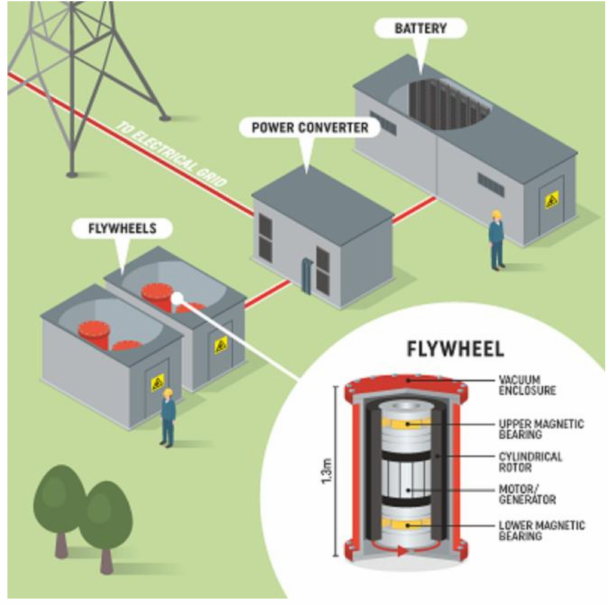
Figure 22. Domestic application of flywheel, adapted from